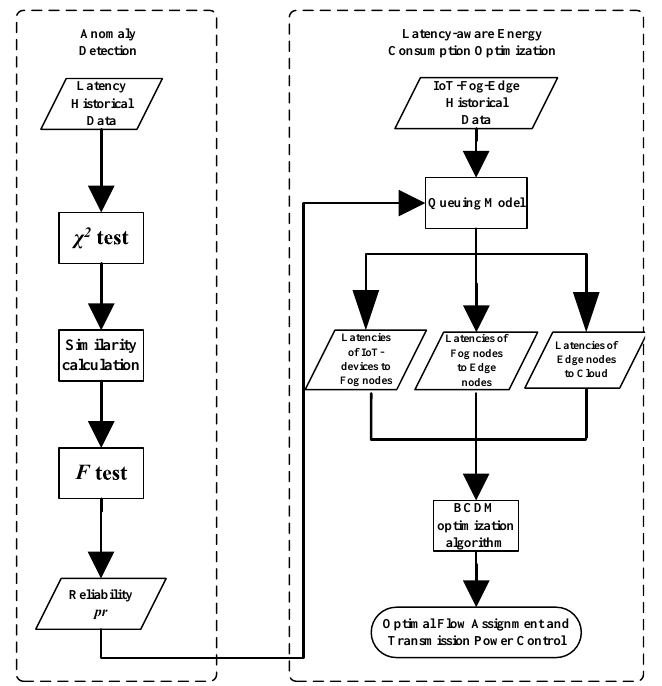
Figure 1. Flowchart of the optimization procedure of